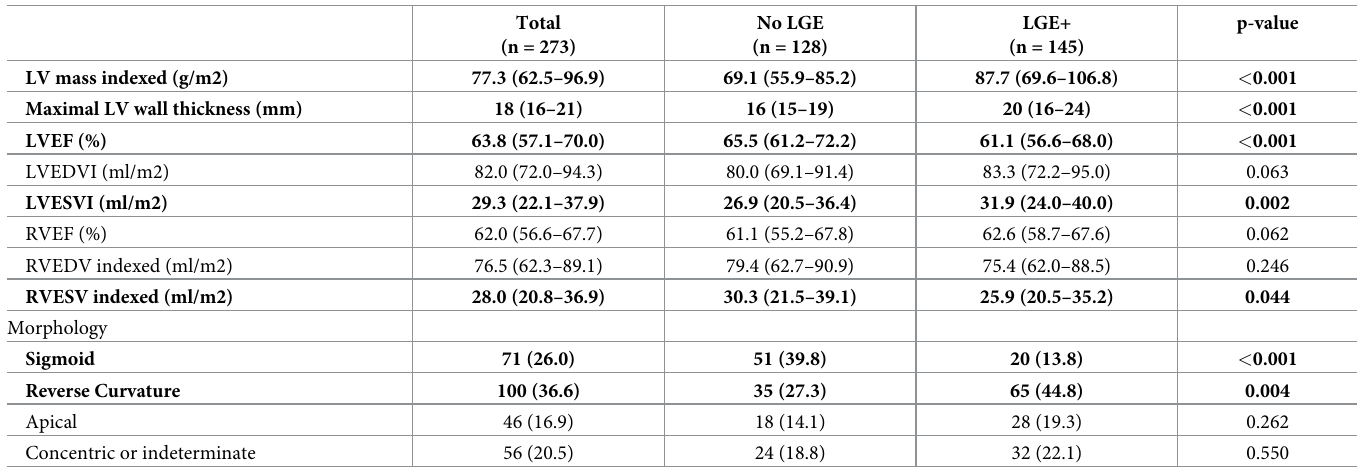
Table 2. CMR characteristics stratified by late gadolinium